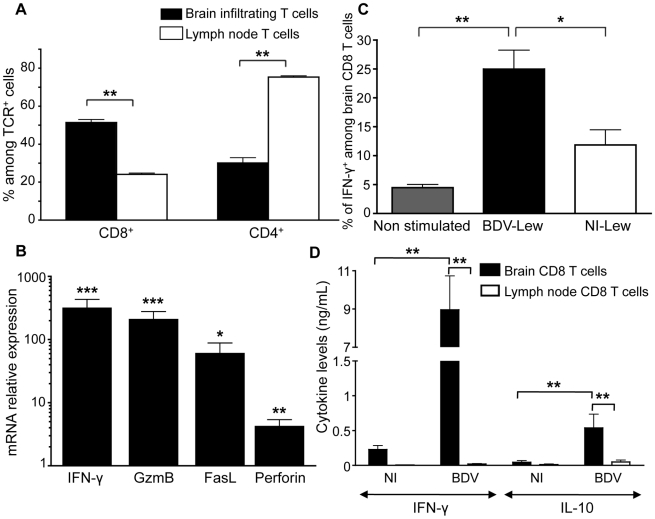
Characteristics of brain-purified CD8 T cells from BDV-infected rats.(A) Percentages of CD8+ versus CD4+ cells among TCRαβ+ cells purified from brain or cervical lymph nodes of infected rats. Values are expressed as means ± sem of six independent experiments **, p<0.01 by Mann-Whitney U-test. (B) Determination by real-time quantitative RT-PCR of the relative mRNA levels of IFN-γ, Granzyme B (GzmB), Fas-ligand (FasL) and Perforin in brain-purified CD8 T cells compared to cervical lymph node CD8 T cells of the same animal. Values were normalized for actin mRNA levels. Values are expressed as means ± sem of four independent experiments. ***, p<0.001; **, p<0.01; and *, p<0.05 by paired Student's t-test. (C) Percentage of IFN-γ-producing cells amongst TCRαβ+CD8+ cells after 48h restimulation with BDV-infected (BDV-Lew) or non-infected (NI-Lew) Lewis fibroblasts, as determined by intracellular FACS staining. Results are expressed as means ± sem of four independent experiments. *, p<0.05; **, p<0.01 by Mann-Whitney U-test. (D) Cytokine levels in supernatants of cocultures of CD8 T cells with neurons. Supernatants were assayed after 48 hours of culture using Luminex multiplex kits. Only levels of IFN-γ and IL-10 are shown (see Figure S1 for other cytokines). Values are expressed as mean concentrations ± sem of four independent experiments. **, p<0.01 by Mann-Whitney U-test.